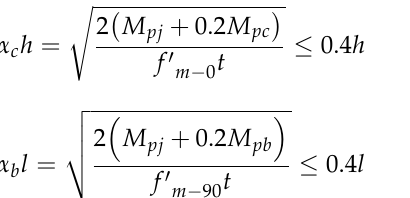
where α c is the ratio of column contact length to height of the column, α b the ratio of beam contact length to span of the beam, h height of the column, l length of the beam, M pj minimum of the column’s plastic moment capacity, M pc and M pb the plastic moment capacity of the column and beam, respectively, f (cid:48) of masonry panel, parallel and normal, respectively, to bed joints and t the thickness of infill wall.